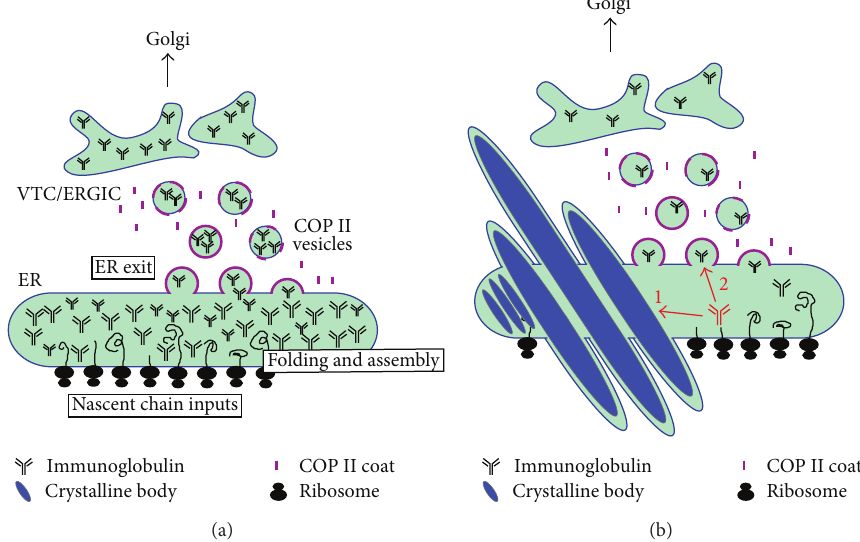
Figure 3: Schematics of early secretory pathway compartments during recombinant IgG overexpression. (a) Increased efficiency in protein synthesis, translocation, and oxidative protein folding, in conjunction with limited capacities at the ER exit sites, can lead to a progressive accumulation of export-ready IgG in the ER lumen. VTC: vesicular tubular cluster. ERGIC: ER-Golgi intermediate compartment. (b) Upon reaching a critical threshold concentration, IgG crystals can form in the ER. Accumulated IgGs support the rapid growth of intra-ER crystals. Crystalline body formation in turn alleviates the crowding in the ER. Newly folded IgG will have two competing fates once the crystalline body phenotype is initiated. The first path is to become part of the growing crystals. The second path is to be packaged into COP II vesicles to exit the ER. After crystalline body is induced, many attempts to increase protein synthesis may not directly translate into a higher protein secretion output due to the two competing